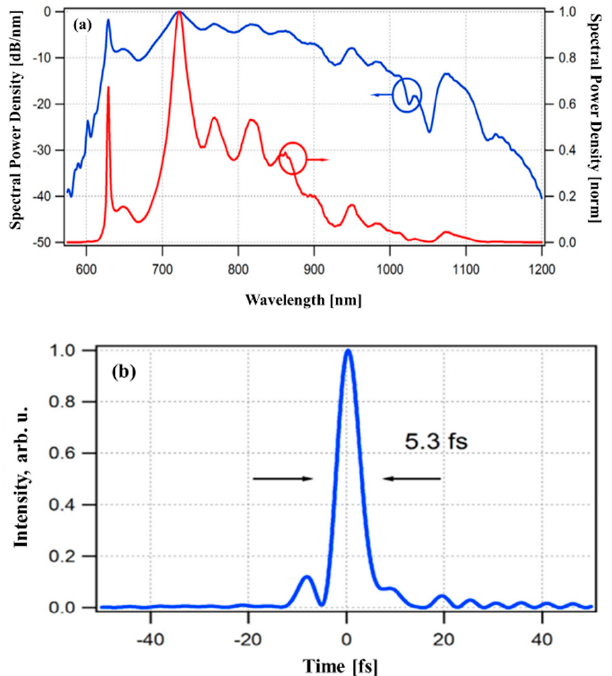
Figure 2. ( a ) Ultra-broad spectrum profile (red line represents the normalized spectral power density, blue line is the spectral power density in dB/nm) and ( b ) few-oscillation-cycle pulse duration of a femtosecond oscillator with chirped mirrors for phase dispersion compensation (Venteon Company).